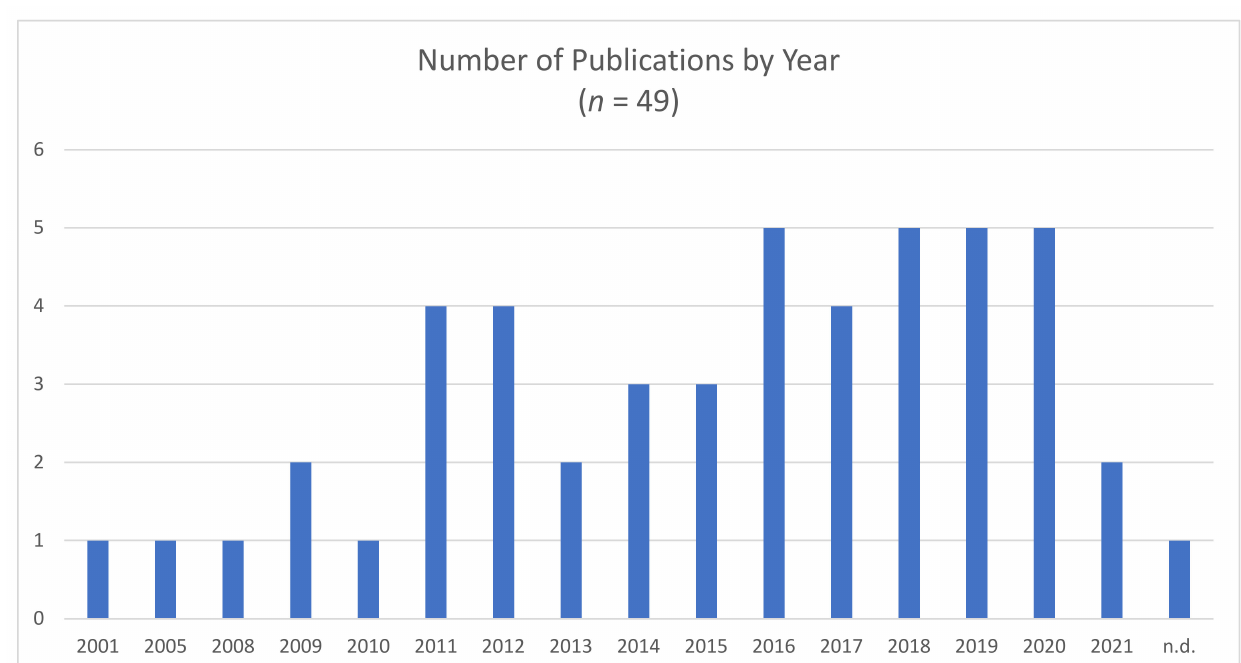
Figure A1. Number of publications by year (2001–2021). One study had no date listed (n.d.).